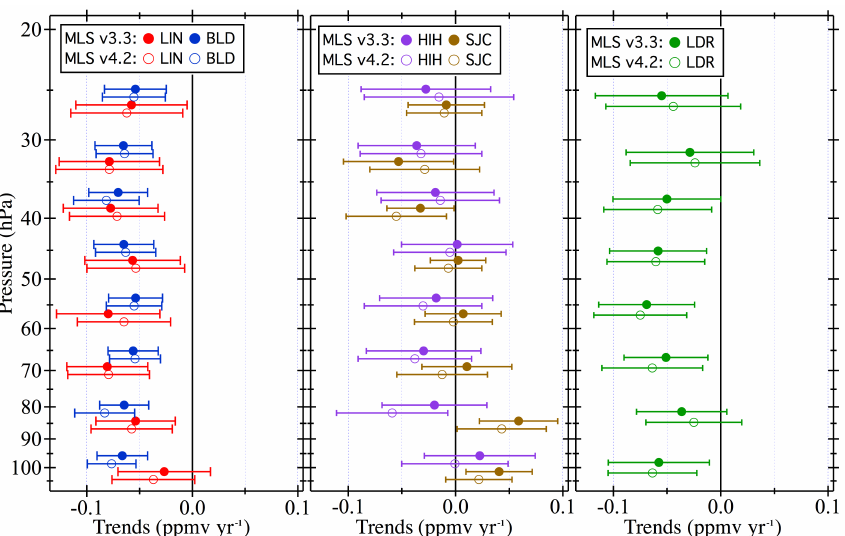
Figure 4. Period 2 trends in FP–MLS differences using MLS v3.3 (filled circles) and v4.2 (open circles) retrievals at eight stratospheric pressure levels (100–26hPa) over the five FP sounding sites. Markers for each pressure level are slightly offset in pressure for clarity. Horizontal error bars depict the 95% confidence intervals of the